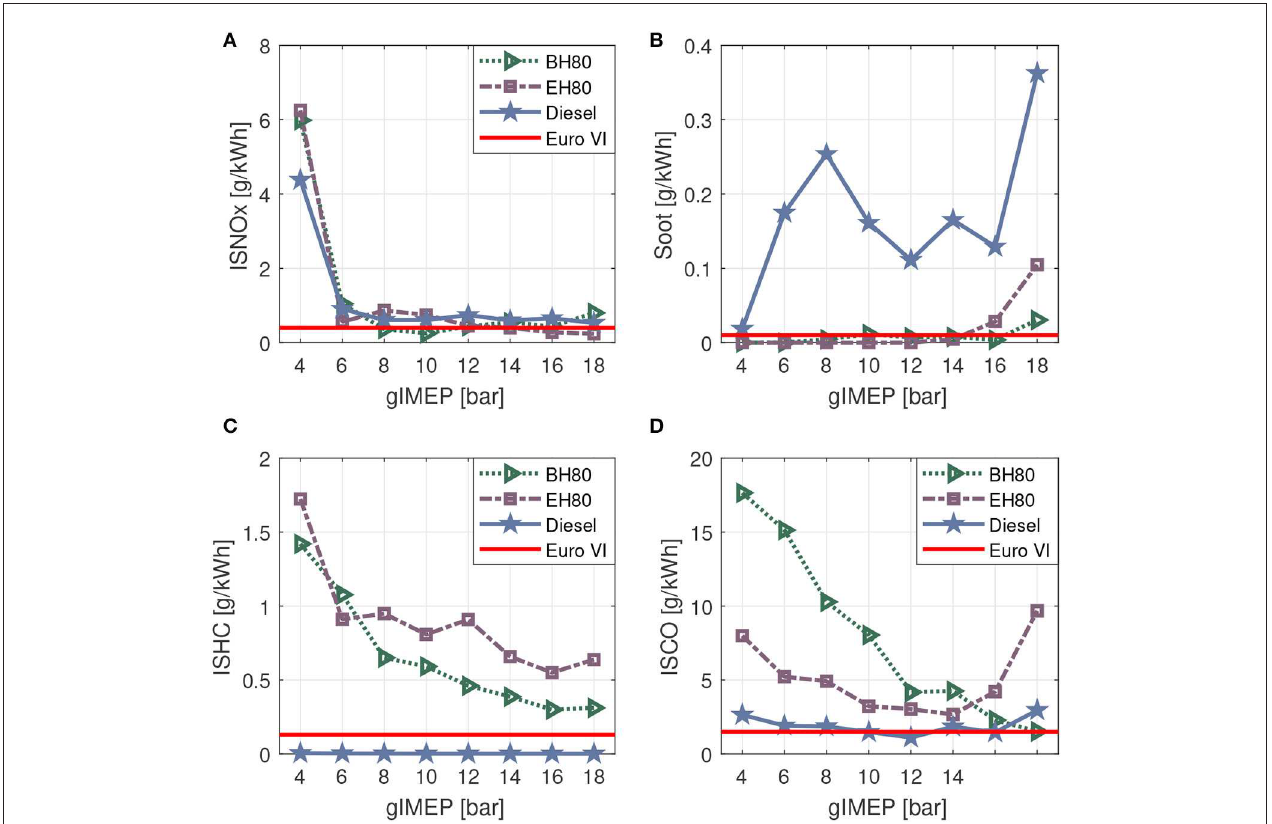
FIGURE 10 | ISNOx (A) , Soot (B) , ISHC (C) , and ISCO (D) as a function of